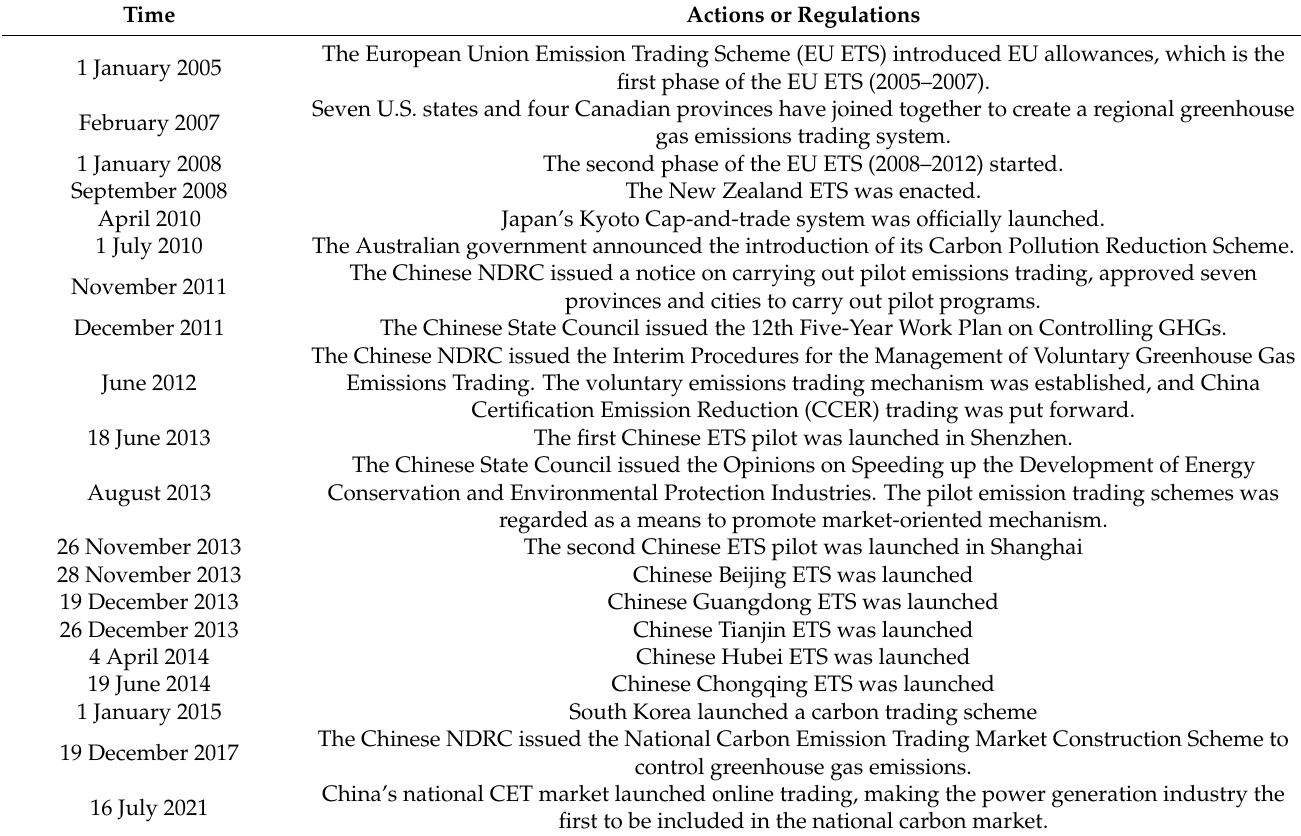
Table 1. The development of history of international and China’s CET